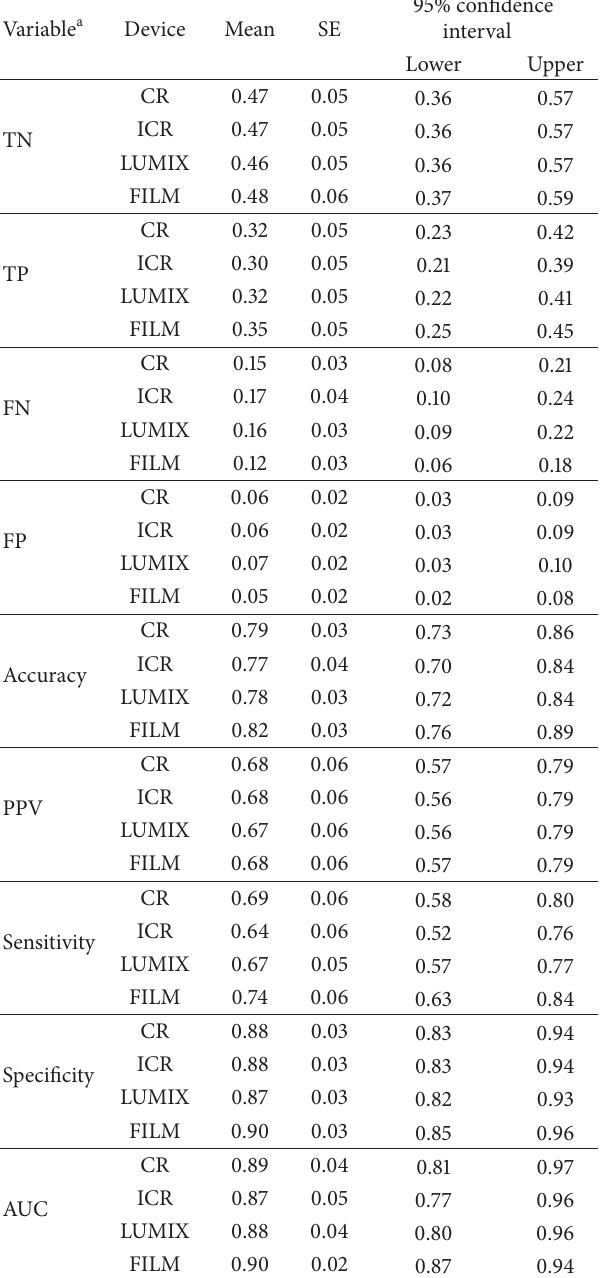
Table 3: Mean values for the calculated variables by